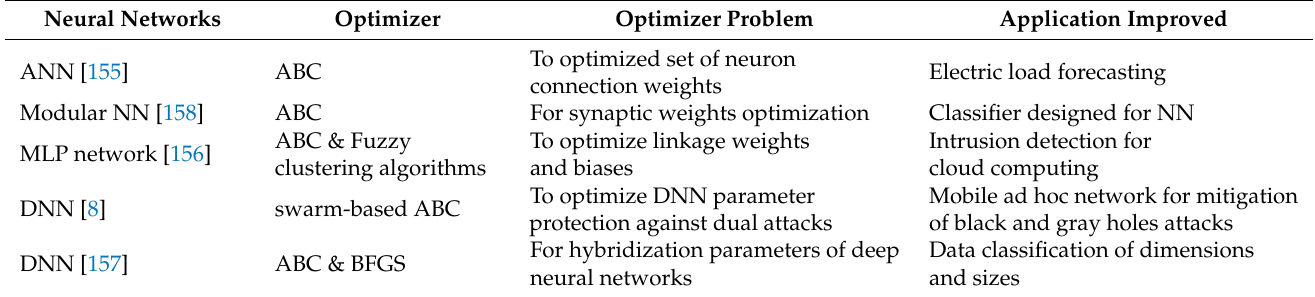
Table 5. Studies involving ABC for neural networks design and application